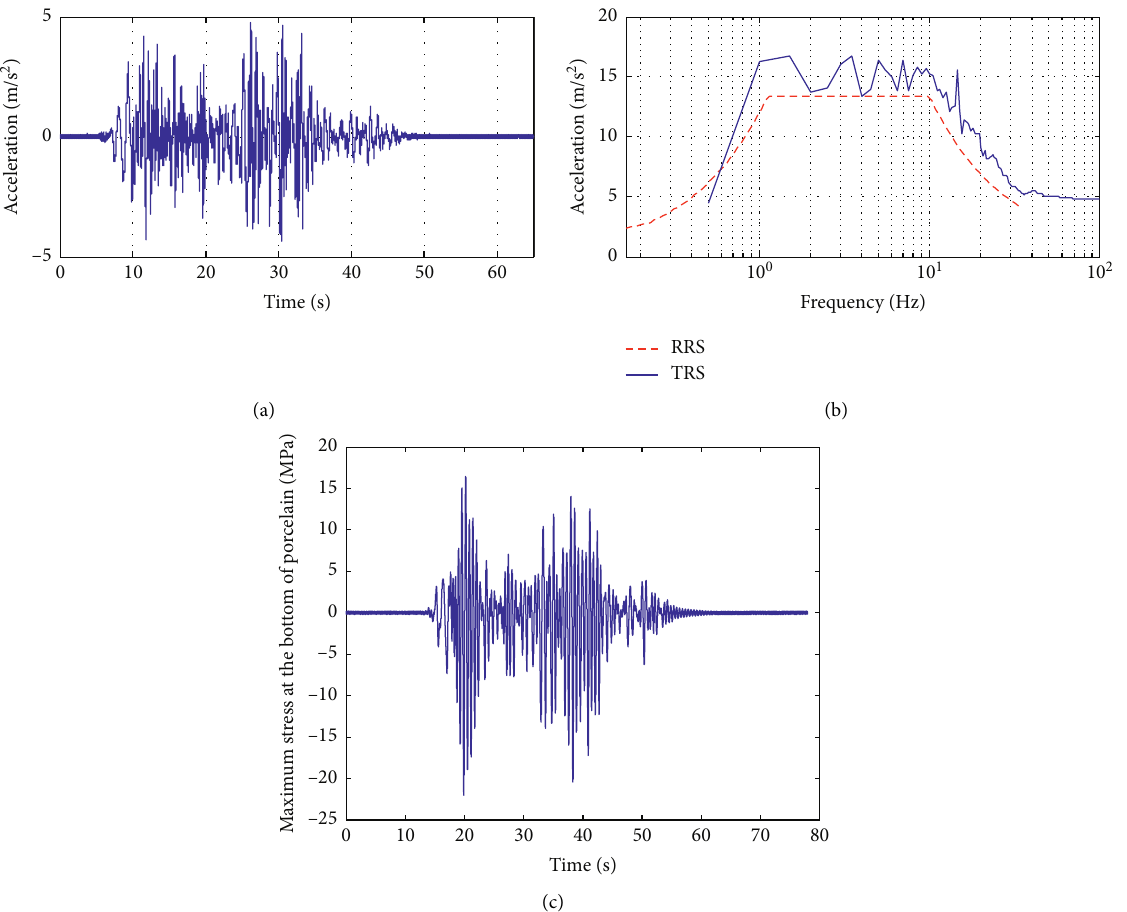
Figure 10: The waveform of shaking table test results (0.3g). (a) Input acceleration time history. (b) Response spectrum. (c) Stress responses at the bottom.